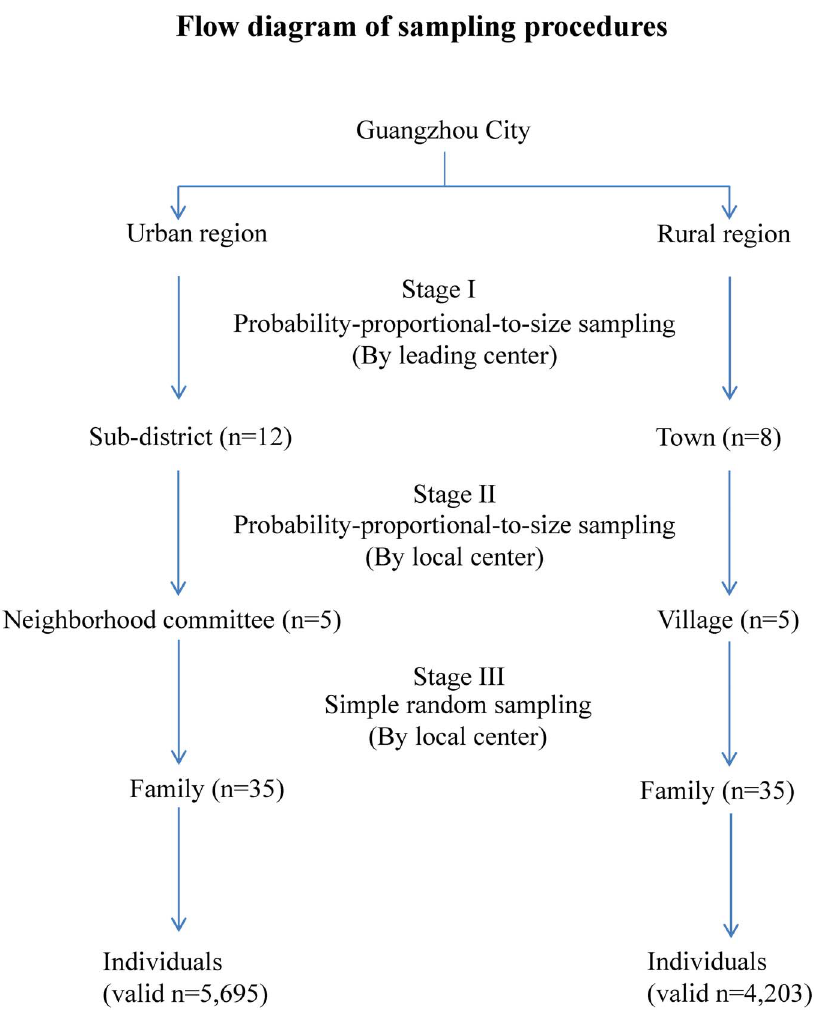
Fig. 1. Flow diagram for sampling methods and procedures in the